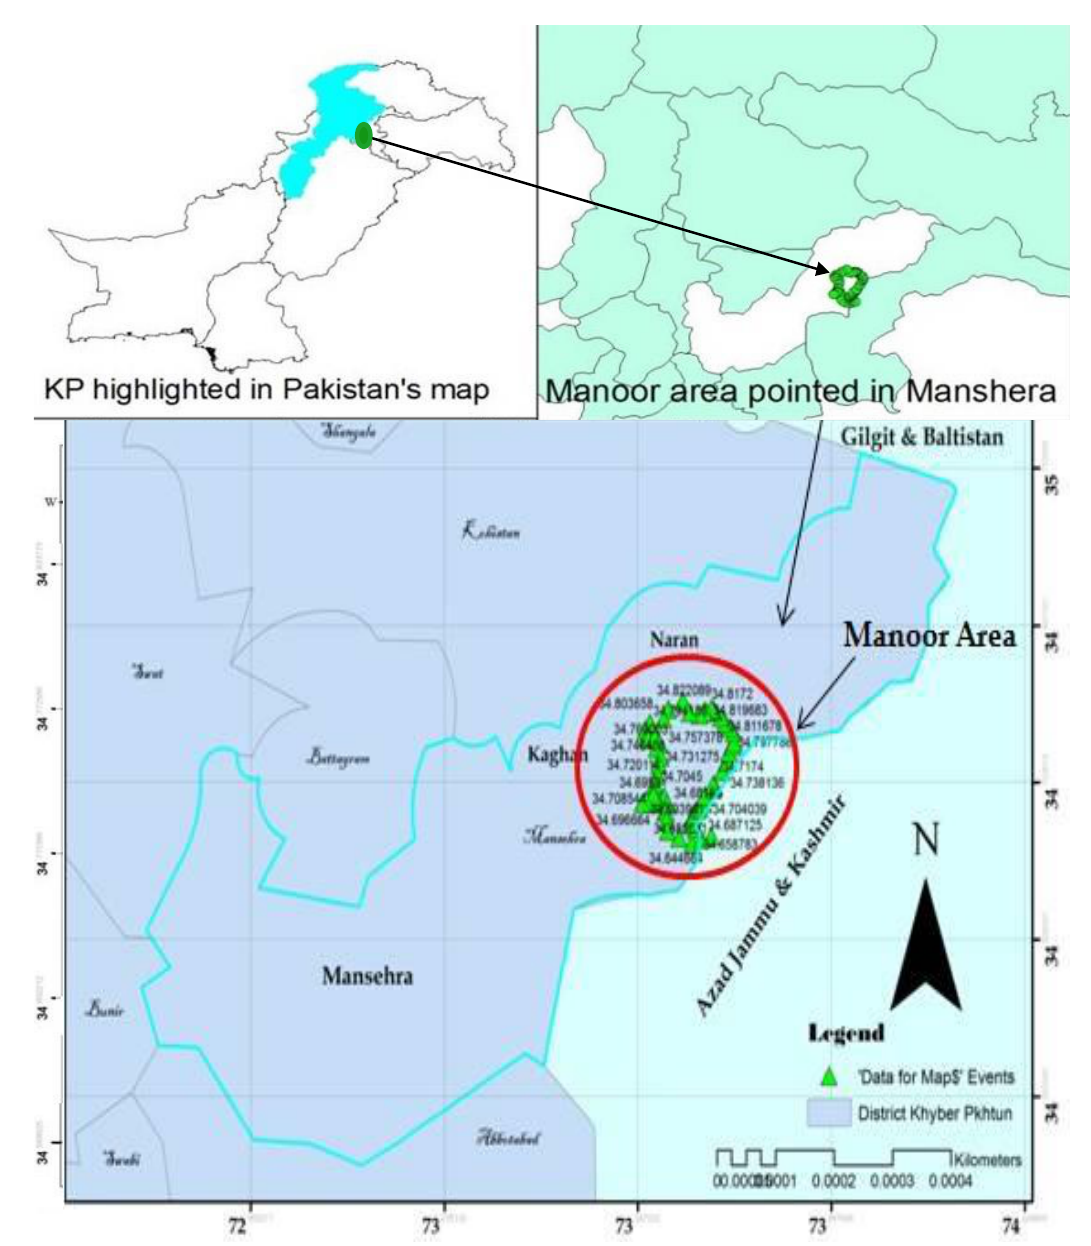
Figure 1. Map of the study area generated through ArcGIS.